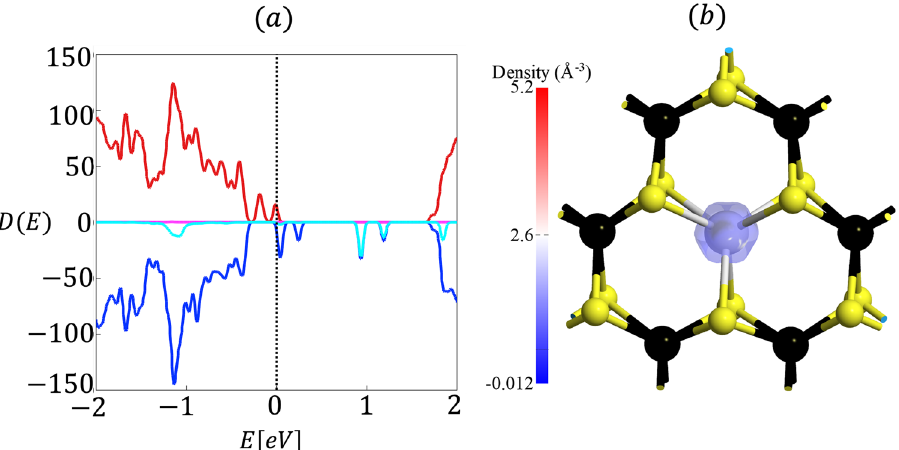
Figure 2. Bandstructure and density of states, shaded grey region shows the total density of states and the colored curves shows the projected density of states (Blue: f -orbitals of the Ho atom, Green: p -orbital of the neighboring S atoms and red: d -orbitals of the next neighbor W atoms) of 8 containing an Ho W impurity. The LDS are clearly visible as dispersionless (localized) states, some of which lie inside the bandgap, others lie inside the valence band of WS 2 . The eigenstates corresponding to the LIS transform according to the IRs of the point symmetry group D 3h . Vertical arrows indicate optical transitions corresponding to resonances shown in Fig. 7.